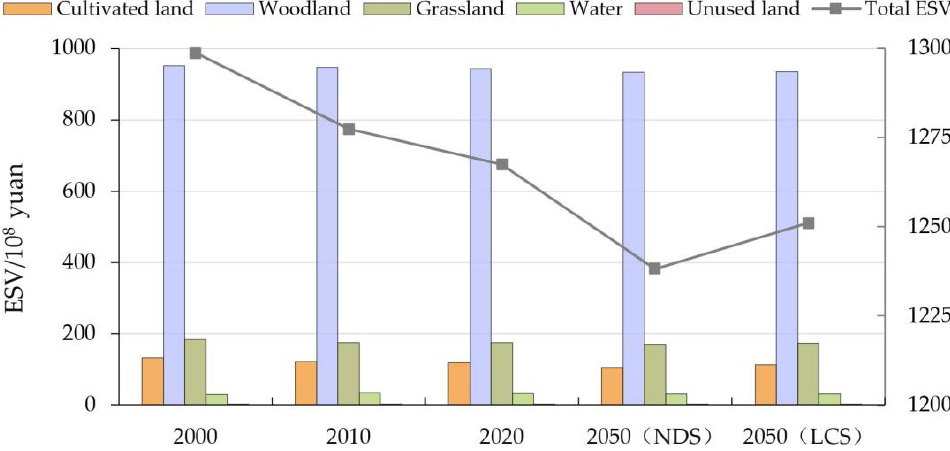
Figure 10. Changes in ecosystem service value (ESV) of different landscapes from 2000 to 2050. Table 3. Changes in ESV of different landscape types from 2000 to 2050.